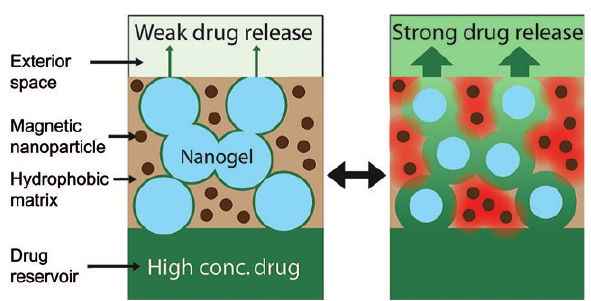
Figure 14 Proposed schematic of a cross section of the membrane, showing nanogel particles (blue), iron oxide nanoparticles (dark brown), and ethyl cellulose matrix (light brown). Upon application of a magnetic fi eld, the magnetic nanoparticles release heat (red) and reversibly shrink the nanogel, enabling release of a drug (green) from a reservoir contained by the membrane [86] . Reprinted with permis- sion from Ref. [86] . Copyright (2011) American Chemical